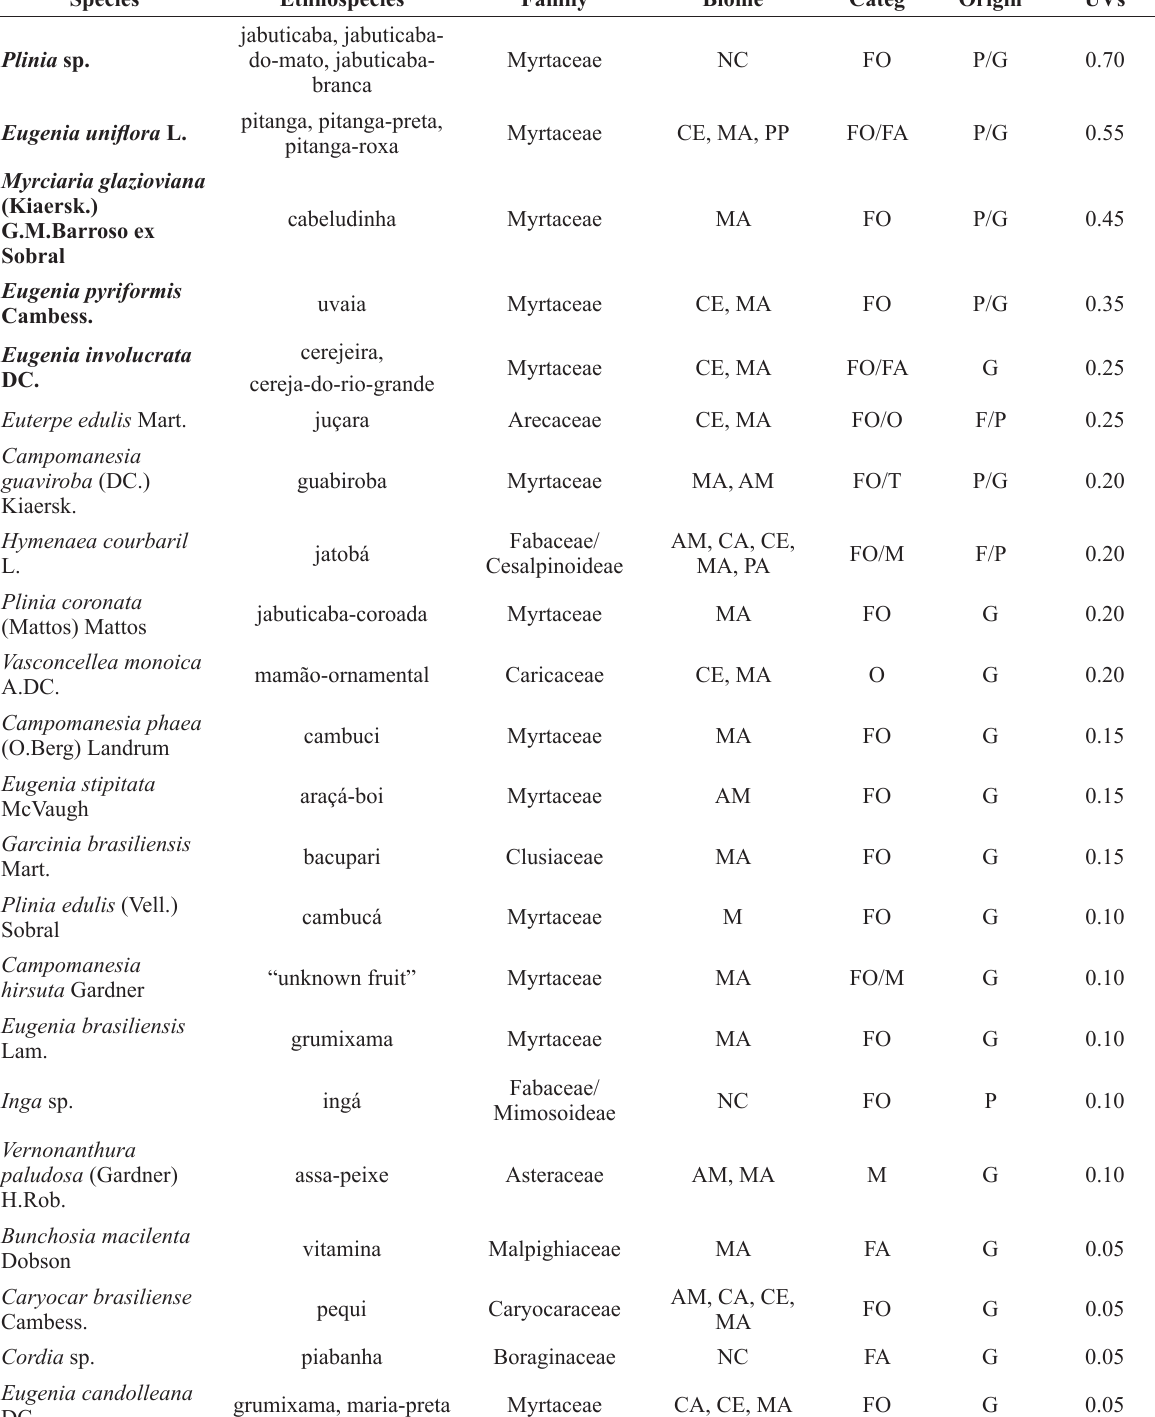
List of all native arboreal species cited by rural dwellers of the mountain region of Espírito Santo, Brazil, in decreasing order of species use-value (UVs), followed by local names (Ethnospecies), botanical family (Family), biome of occurrence (Biome), use category (Categ), and